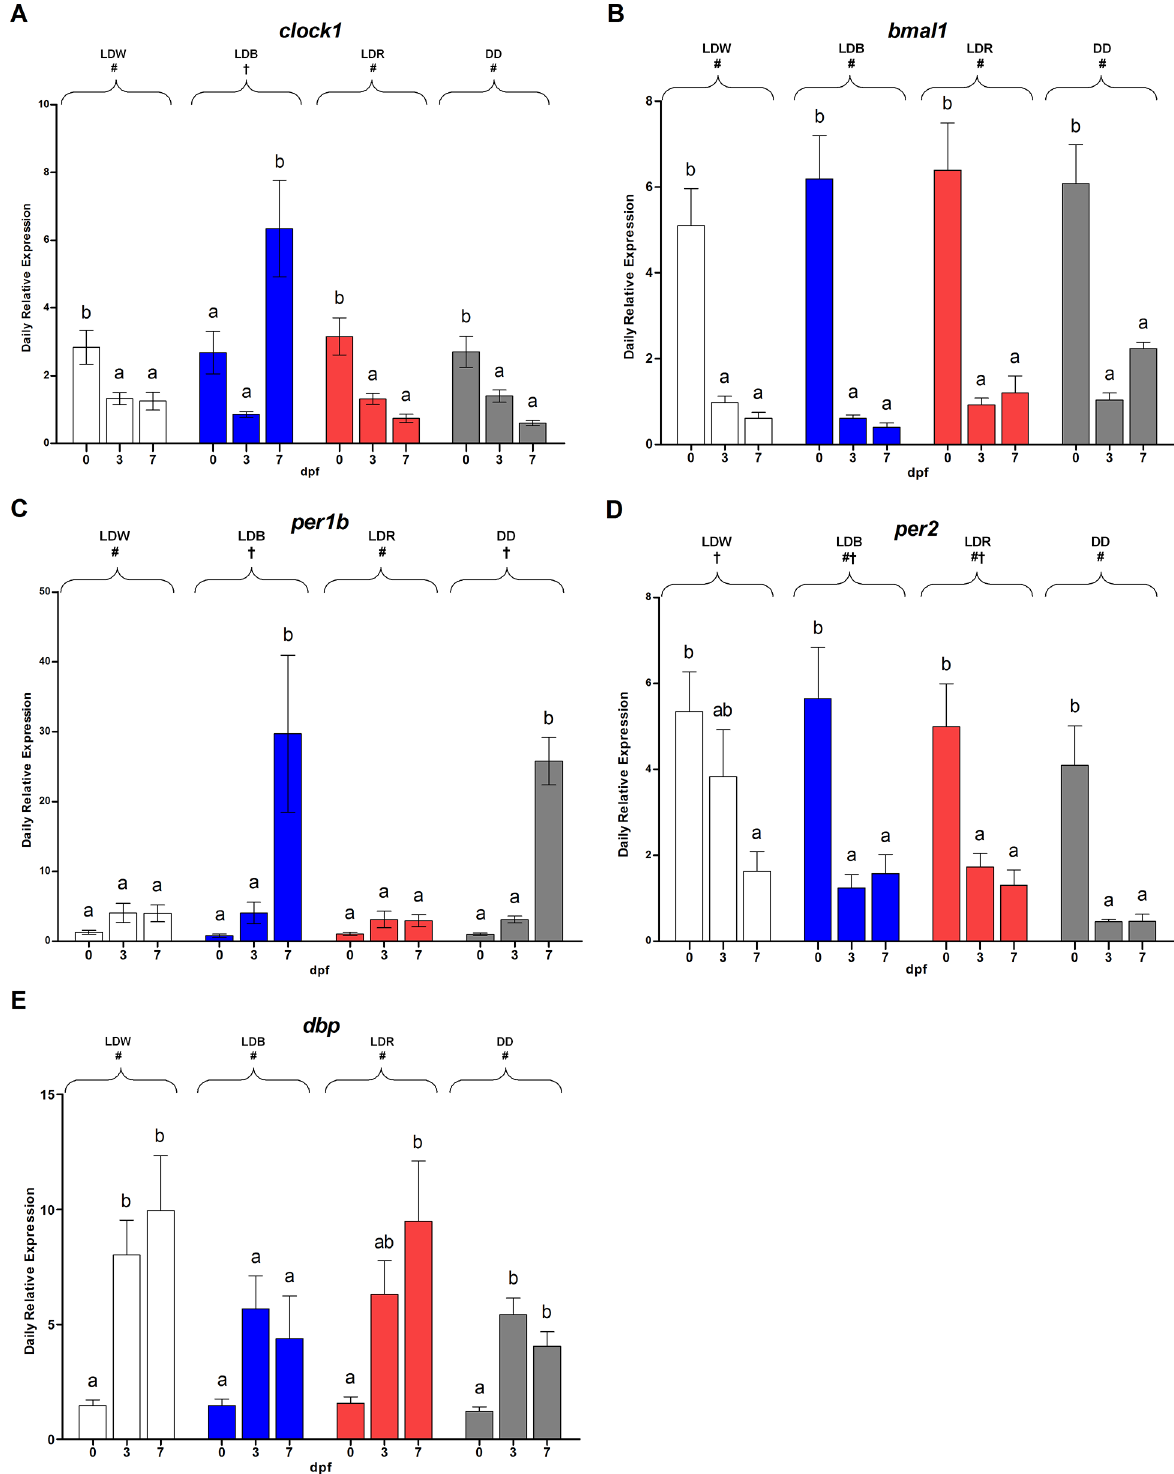
Fig 5. Daily expression levels at 0, 3, 7 dpf of clock1 bmal1 , per1b , per2 and dbp under different lighting conditions. The data are expressed as mean ± SEM. The letters above each bar indicate significant differences for each condition among the days (one-way-ANOVA, p < 0.05). The symbols on the top indicates statistically differences between the lighting conditions (two-way-ANOVA, Tukey ’ s post-hoc test, p < 0.05).